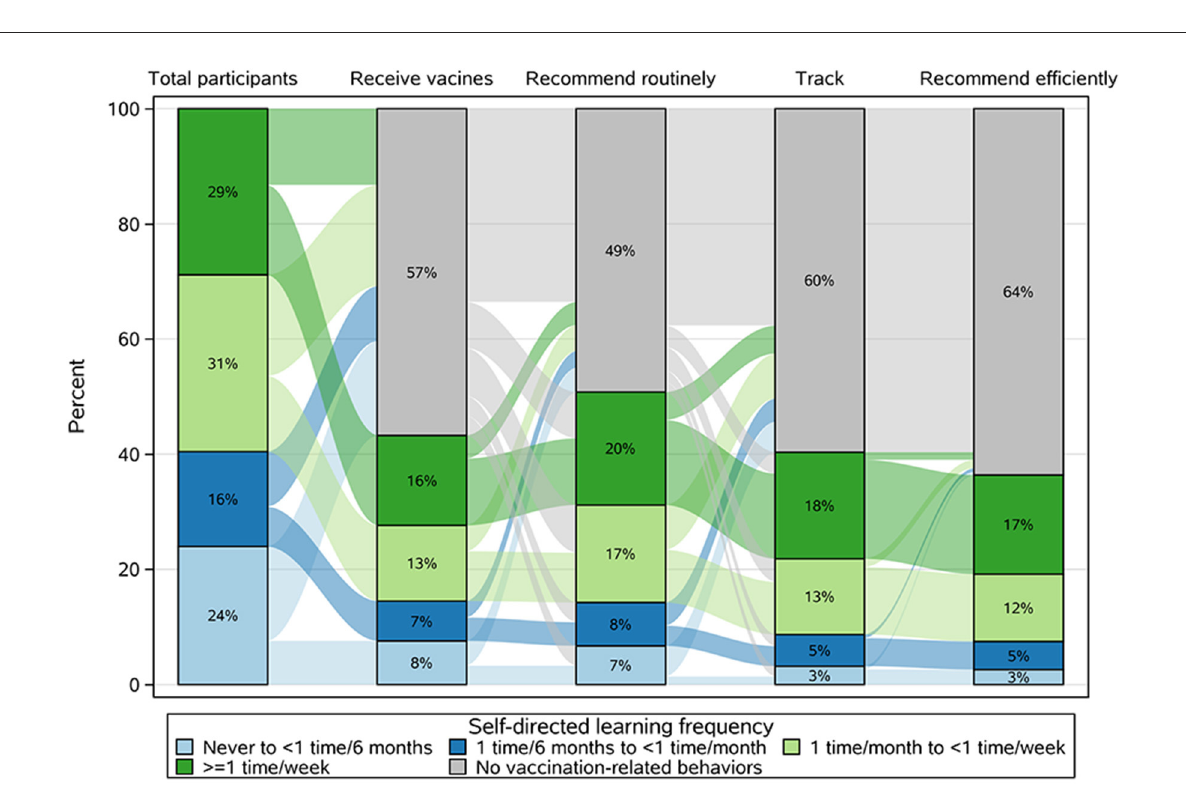
FIGURE2 Sankey diagram showing the pattern of vaccination-related behaviors among participants with different SDL